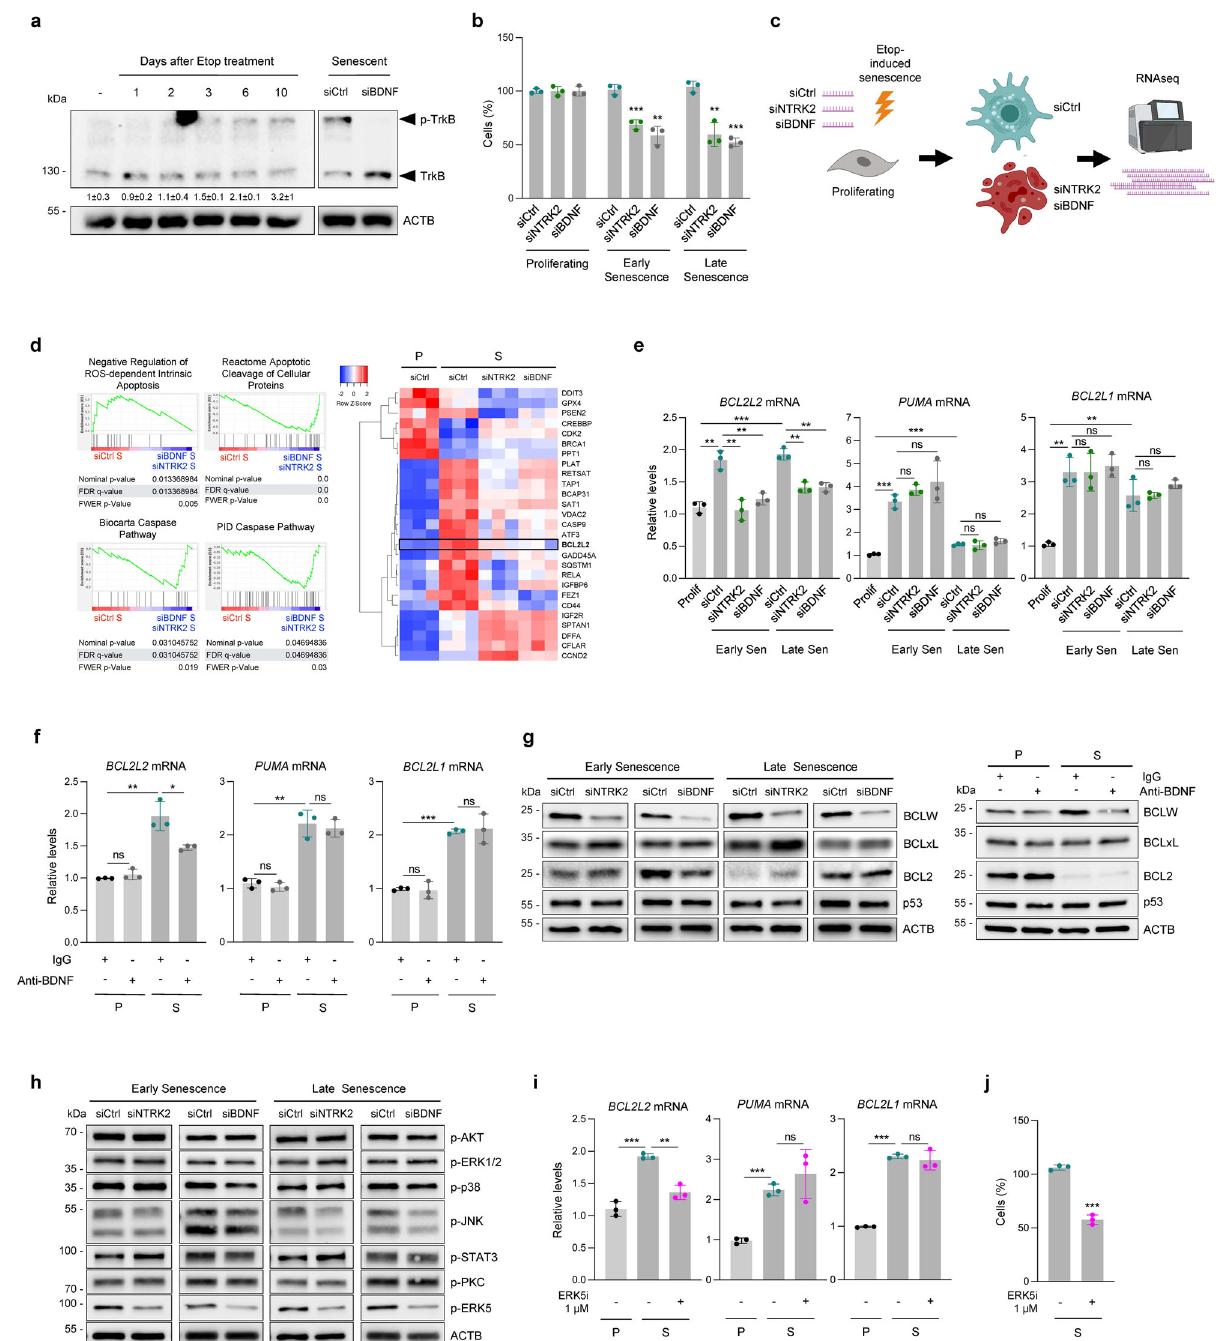
Fig. 5 | ERK5 activationby TrkB-BDNFsustains senescent cell survivalthrough BCL2L2. a Western blot analysis using PhosTag gels to separate phosphorylated (p- TrkB) from unphosphorylated TrkB in WI-38 cells progressing to senescence ( left ), as wellasincellstransfectedtoexpressnormal(siCtrl)orreduced(siBDNF)BDNFlevels ( right ). Phosphorylation ratios (p-TrkB/TrkB) were calculated (means±SD) relative to day 0. b WI-38 fi broblasts transfected with siCtrl, siNTRK2, or siBDNF were treated withetoposide(50 μ M)andcellviabilitywasmeasuredbydirectcellcountingatearly senescence (day 2) and late senescence (day 8). c Experimental design for RNA-seq analysis to evaluate transcriptomic differences among cell groups; created using BioRender. d TranscriptomicanalysisofWI-38cellsinthegroupsexplainedin c ;GSEA associations ( left ), and heat map depicting genes related to apoptosis that changed signi fi cantly in cells transfected with siNTRK2 or siBDNF ( right ). e WI-38 cells were processedasin b andthelevelsof PUMA , BCL2L2 ,and BCL2L1 mRNAswerequanti fi ed by RT-qPCR analysis. f WI-38 cells were treated with IgG or BDNF-blocking